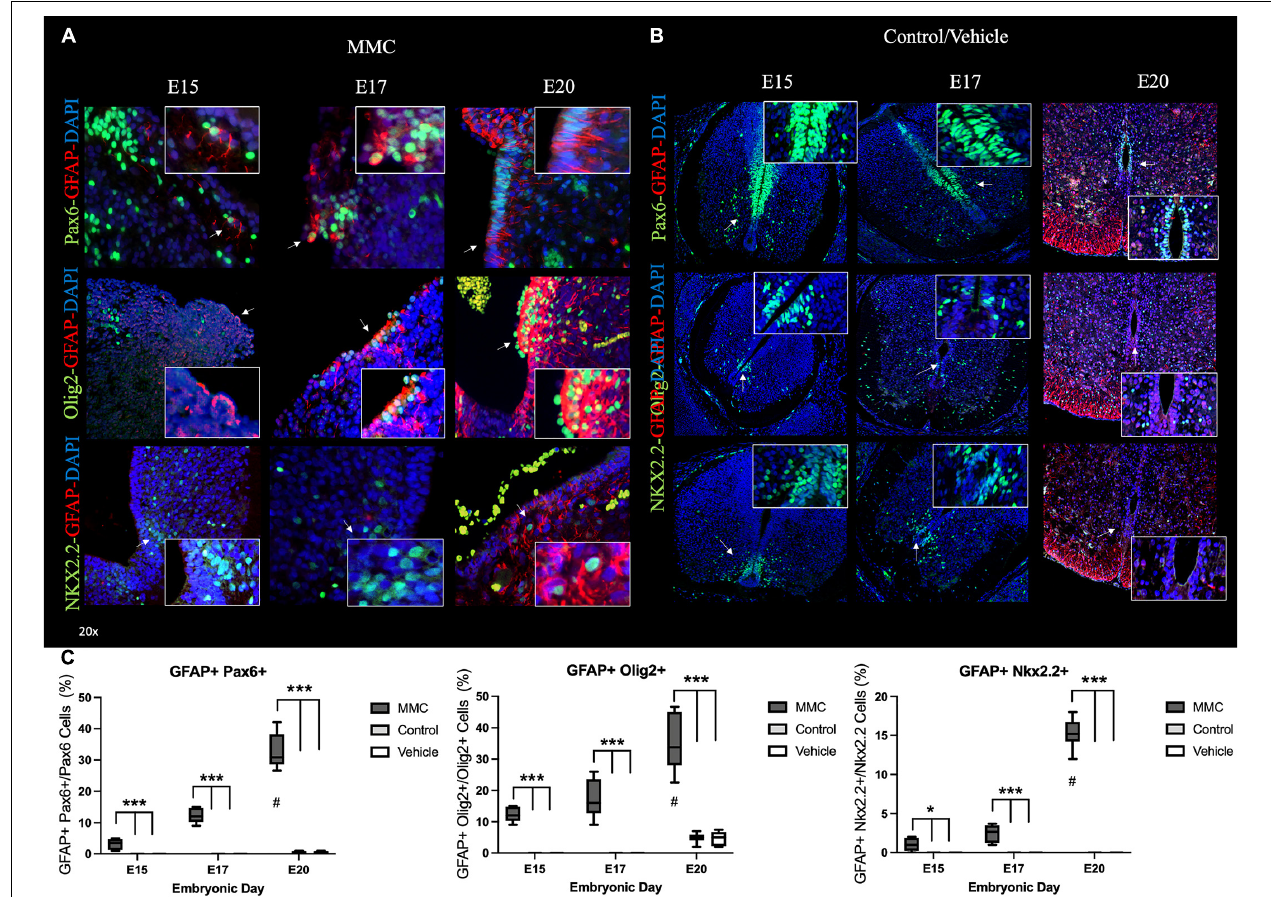
FIGURE 9 | Early NPC differentiation into astrocytes in spina bifida. Progressive early generation of reactive astrocytes in (A) MMC compared with (B) control spinal cords at E15, E17, and E20. (A) Pax6 + GFAP+ cells located in the VZ exposed to the amniotic fluid in spina bifida at E15, E17, and E20 (upper) (arrow). Olig2 + GFAP+ cells located in the VZ exposed to the amniotic fluid in spina bifida at E15, E17, and E20 (center) (arrow). Nkx2.2 + GFAP+ cells located in the VZ exposed to the amniotic fluid in spina bifida at E20 (bellow) (arrow). (B) Ventricular zone (VZ) is divided into three domains along the dorsoventral axis: Pax6 (p0-2), Olig2 (pMN), and Nkx2.2 (p3) domains and GFAP sub-pial expression in normal spinal cords. Pax6 (green), Olig2 (green), Nkx2.2 (green), GFAP (red), and DAPI (blue) (20 × images). (C) % GFAP Pax6+, GFAP+ Olig2+ and % GFAP+ Nkx2.2 astrocytes in spina bifida, control and vehicle spinal cords determined by GFAP and Pax6, Olig2, or Nkx2.2 stained cells/Pax6, Olig2, or Nkx2.2 at three gestational ages E15, E17, and E20 (means ± SD, * p < 0.05, *** p < 0.001, # p < 0.05 between E20 and